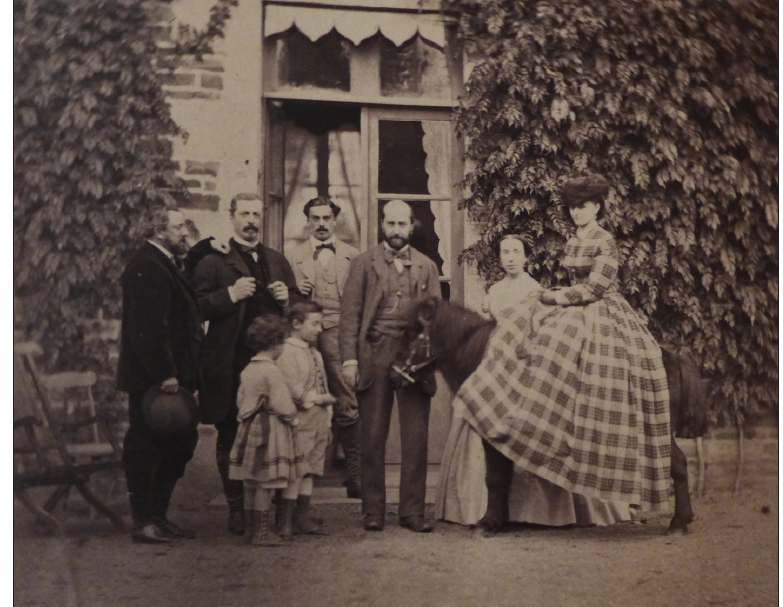
Fig. 4 : Richard and Georges Wallace (behind the children, second and third on the left) in a photograph taken while staying with friends, c. 1862–63. The photograph is in an album annotated with the names of the people shown in the photographs. Private